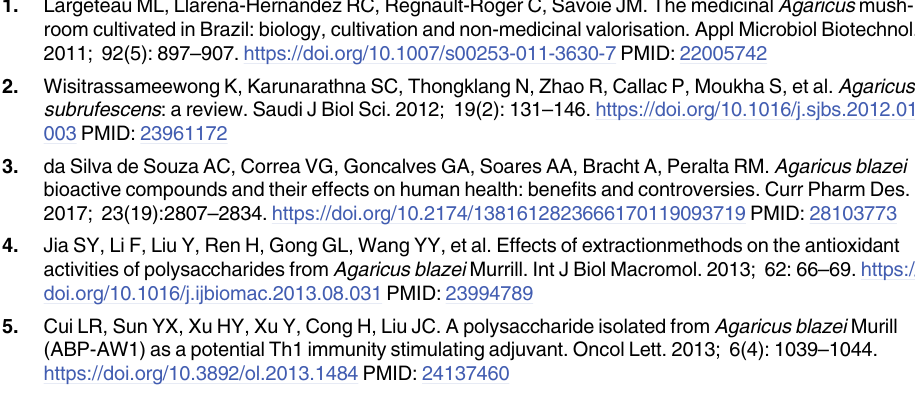
S3 Table. Length distribution of assembled transcripts and unigenes from two A . brasilien- sis strains. S4 Table. Summary of the functional annotation of assemble unigenes in A . brasiliensis mycelia. S5 Table. DEGs were identified simultaneously in J1Cd2 vs J1Cd0, J1Cd5 vs J1Cd0,